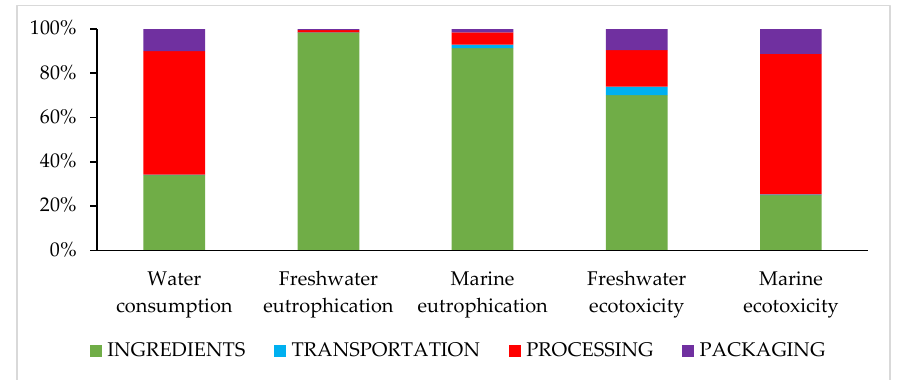
Figure 1. Proportional contribution of each phase of meat analog production to the five environmental Figure 1. impacts.